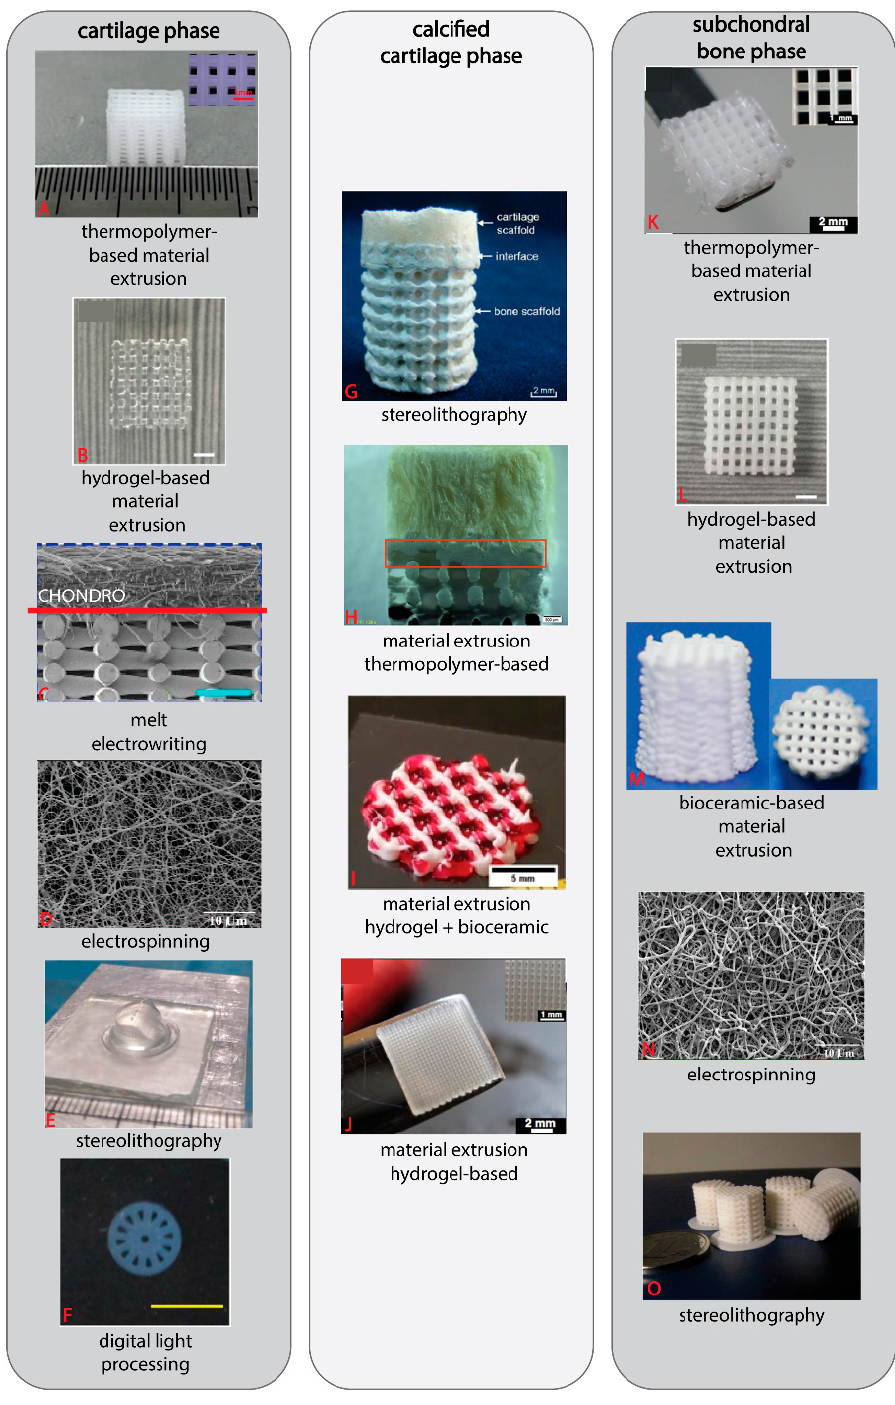
Figure 4. OC scaffold phases made via various 3D printing techniques. Some techniques, such as ME printing for thermopolymers and hydrogels, are commonly used across all phases of the OC scaffold, while other techniques, such as MEW, are commonly used only in one or two phases (cartilage and calcified cartilage). ( A ) Insert scale bar = 1 mm [183]. ( B ) Scale bar = 2 mm [113]. ( C ) Scale bar = 1 mm [184]. ( D ) Scale bar = 0.01 mm [165]. ( E ) [123]. ( F ) Scale bar = 5 mm [103]. ( G ) Scale bar = 2 mm [181]. ( H ) Scale bar = 0.5 mm [143]. ( I ) Scale bar = 5 mm [109]. ( J ) Scale bar = 2 mm, insert scale bar = 1 mm [104]. ( K ) Scale bar = 2 mm, insert scale bar = 1 mm [104]. ( L ) Scale bar = 2 mm [113]. ( M ) [156]. ( N ) Scale bar = 0.01 mm [165]. ( O )